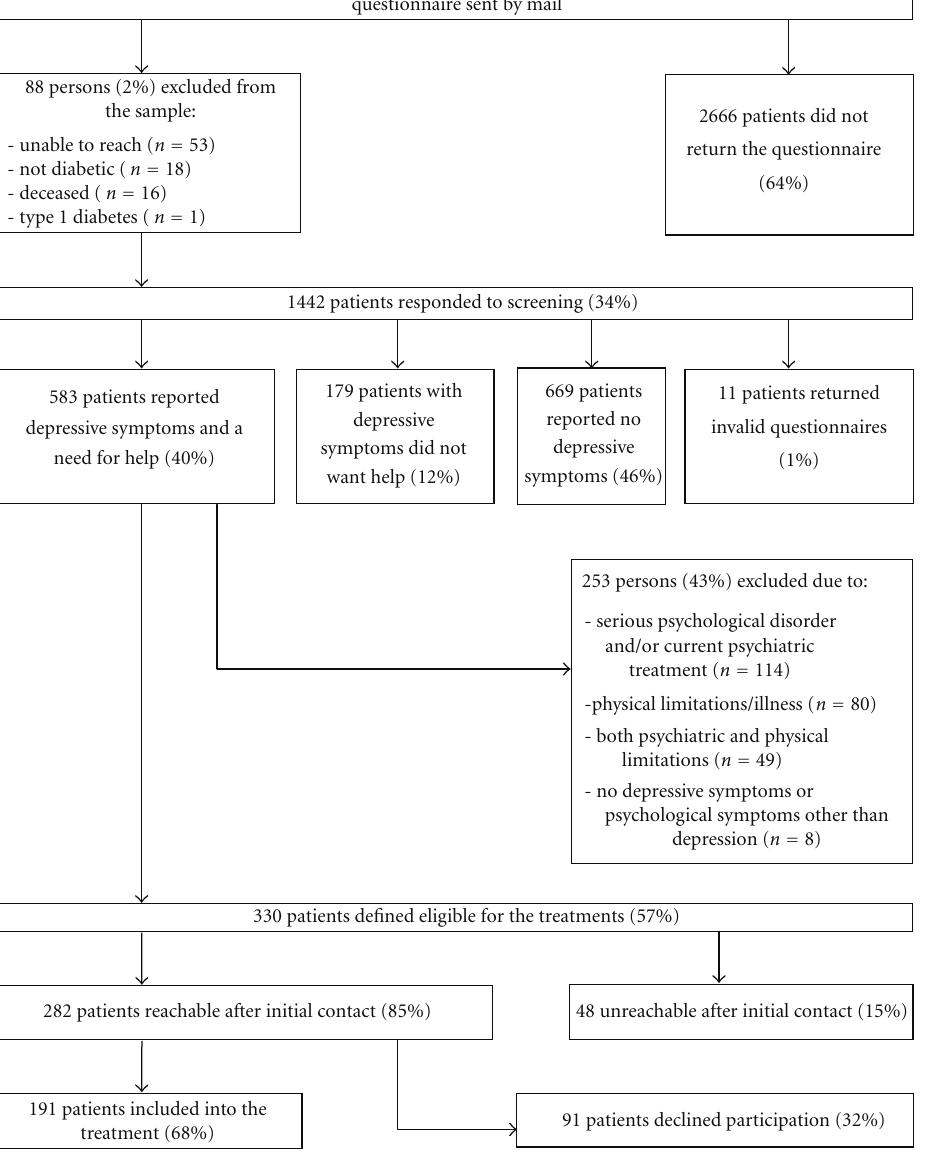
Figure 1: Flowchart of 4196 type 2 patients identified and recruited for trial